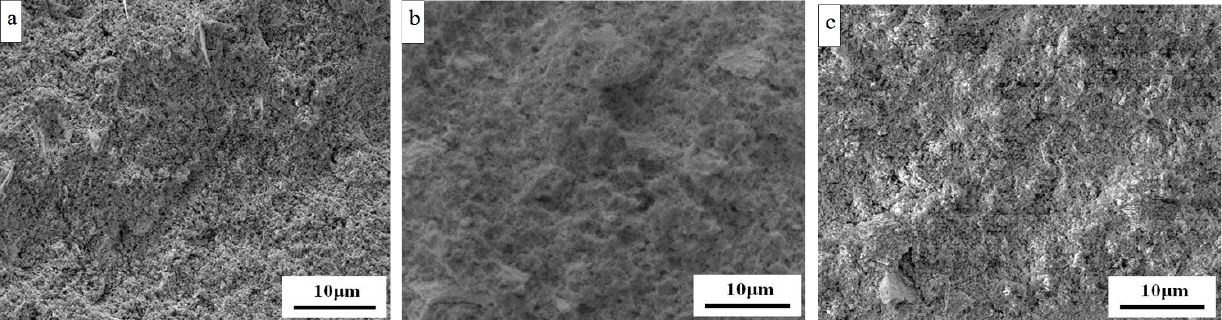
Figure 6. SEM images of fracture surfaces of green parts formed from various feedstocks: ( a ) FS-55; ( b ) FS-65; ( c ) FS-70. ( b ) FS-65; ( c )